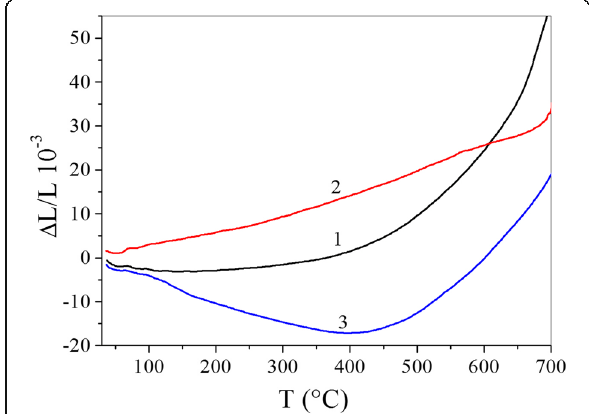
Fig. 1 The relative variation in length, Δ L / L , with temperature of the three materials: Cu-Ti ( 1 ), Cu-Ti 1 vol% MWCNTs ( 2 ) and Cu-Ti 3 vol%